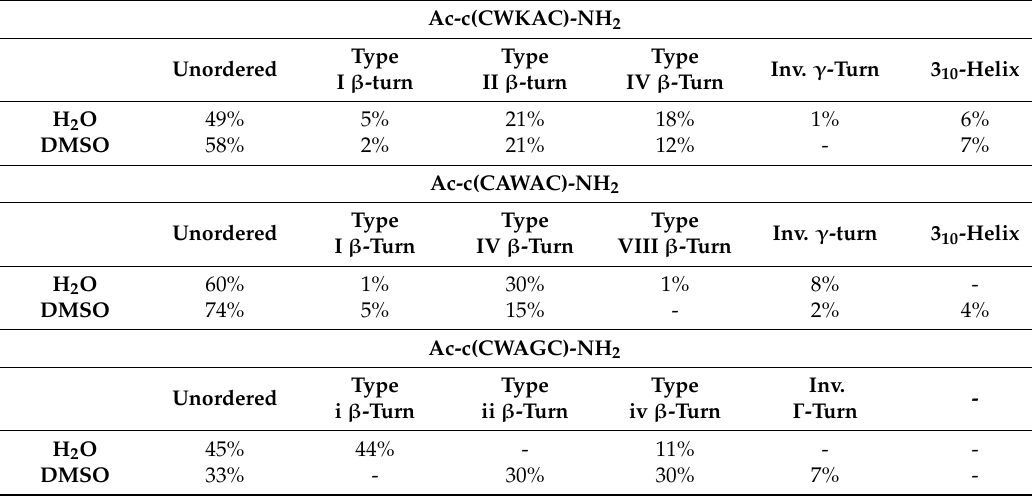
Table 2. Secondary structure analysis of MD